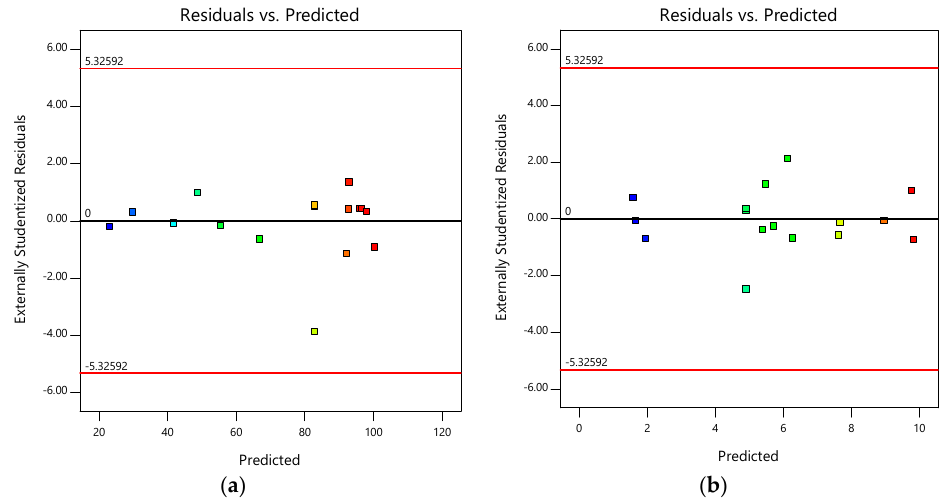
Figure 3. Plot of residuals vs. predicted for ( a ) sulphate reduction efficiency and ( b ) sulphate reduction rate.